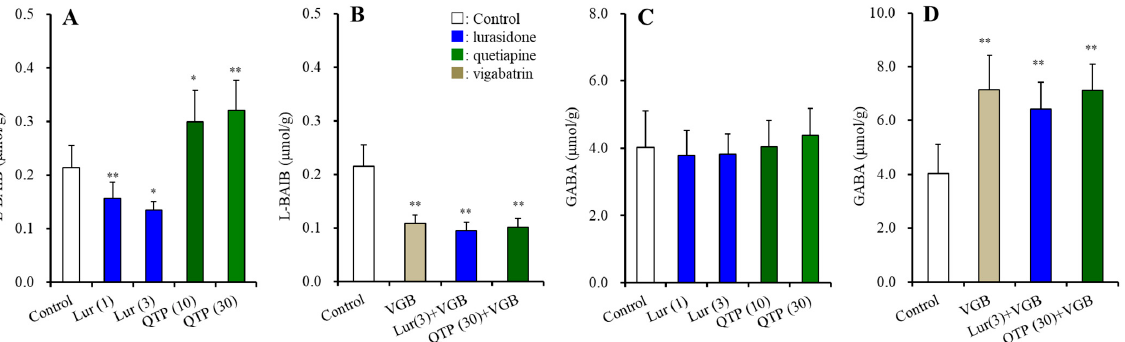
Figure 3. Effects of chronic administration of lurasidone (Lur: 1 and 3 mg/kg/day for 14 d), quetiap- ine (QTP: 10 and 30 mg/kg/day for 14 d), and co-administration of vigabatrin (VGB: 75 mg/kg/day) with lurasidone (3 mg/kg/day) or quetiapine (30 mg/kg/day) for 14 d on hypothalamic levels of L-BAIBA ( A , B ) and GABA ( C , D ). Ordinates indicate mean ± SD ( n = 6) of levels of L-BAIBA or GABA in the rat hypothalamus (µmol/g protein). *: p < 0.05, **: p < 0.01: relative to control by ANOVA with Tukey’s post hoc test.